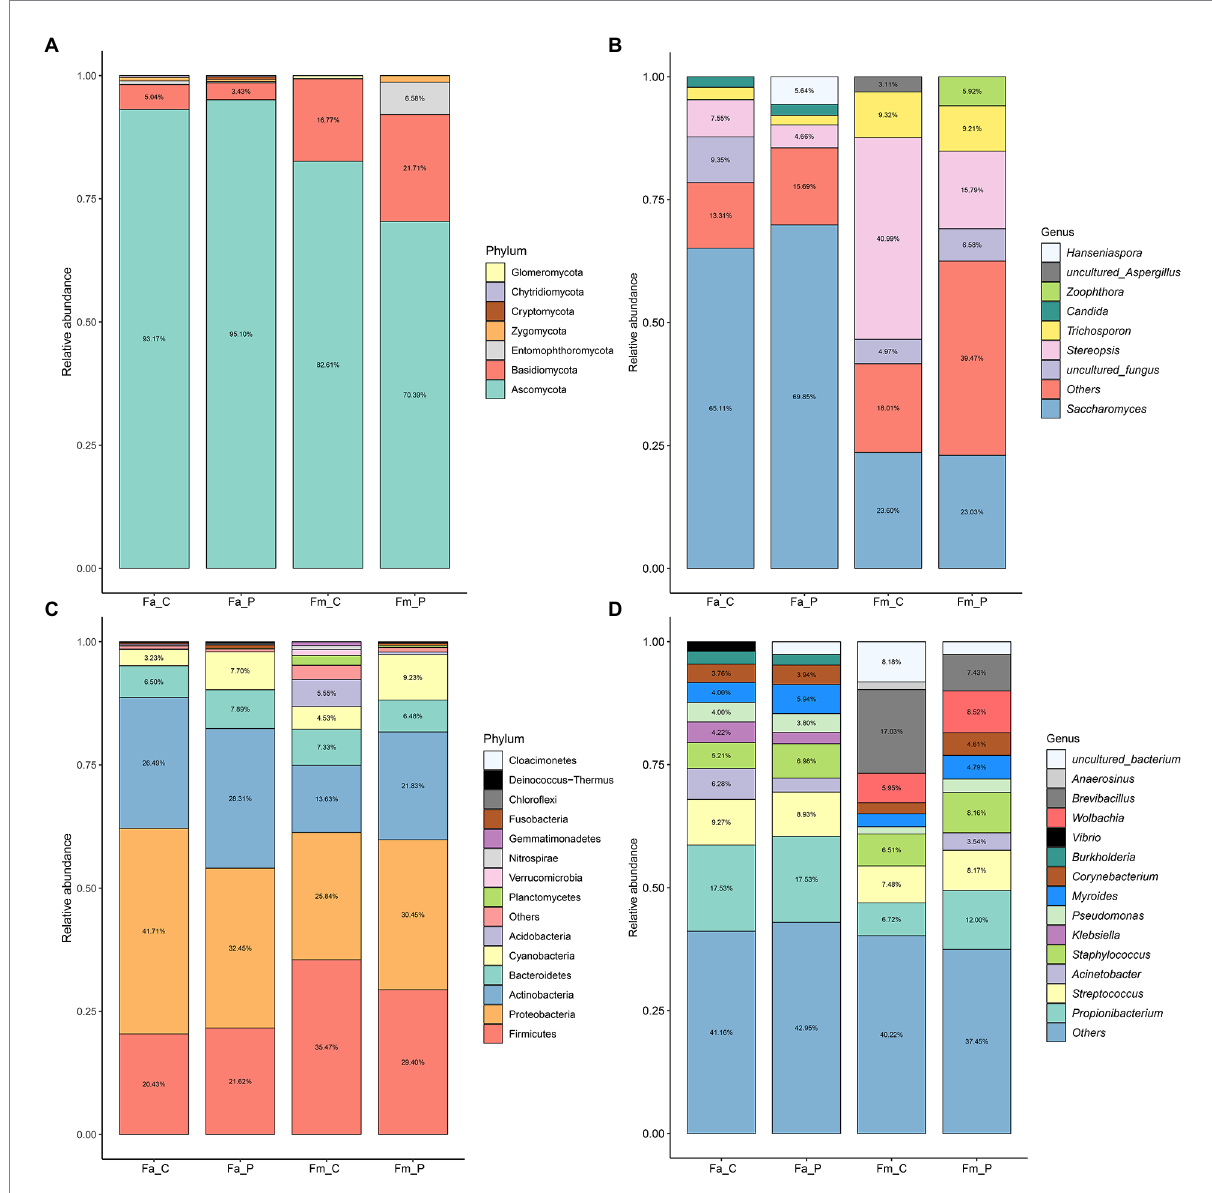
FIGURE 3 The relative abundance of fungal and bacterial communities in four different samples from fig wasps-associated microbial communities. (A) Fungal compositions at phylum level. (B) Fungal compositions at genus level. (C) Bacterial compositions at phylum level. (D) Bacterial compositions at genus level. The percentage is the relative abundance, the values less than 3% were not shown in panel. Fa_C represents the cheater of F. altissima ; Fa_P represents the pollinator of F. altissima ; Fm_C represents the cheater of F. microcarpa ; Fm_P represents the pollinator of F. microcarpa